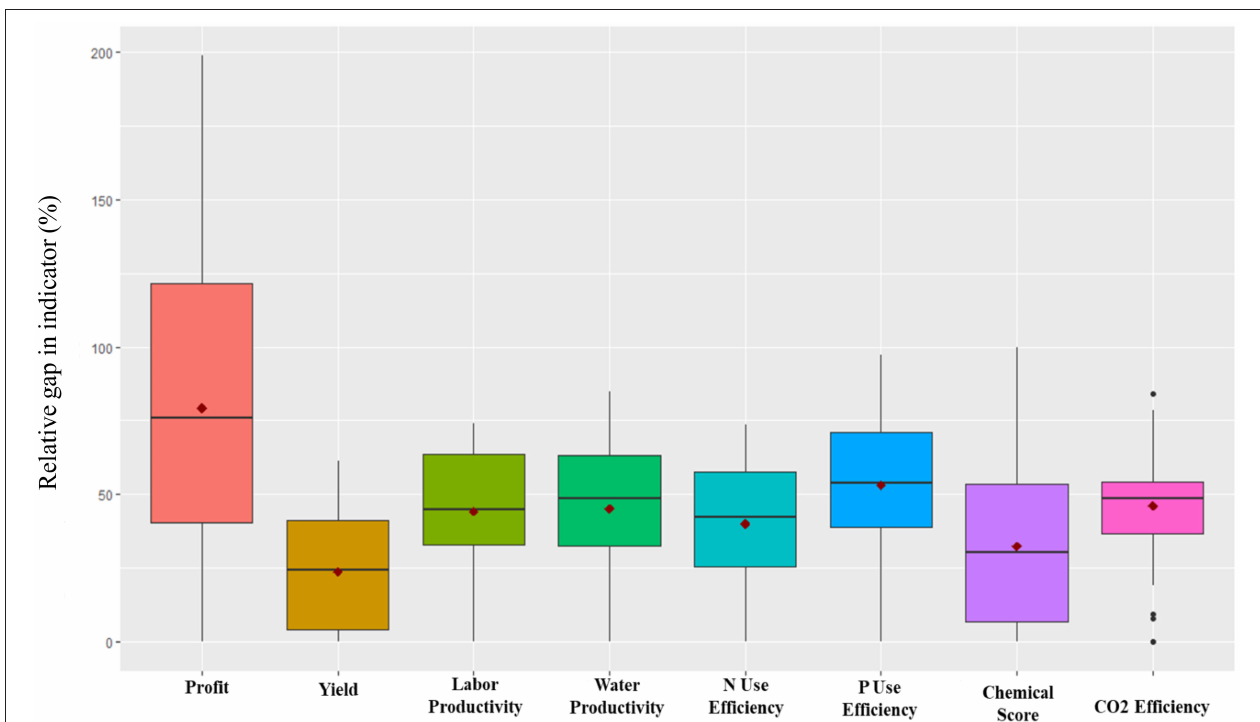
FIGURE 4 | Percent gap for SRP indicators calculated among farmers as the percent difference between the mean of the top 20% (target) and the population mean (baseline) for 65 farmers in Ferreñafe, Peru.